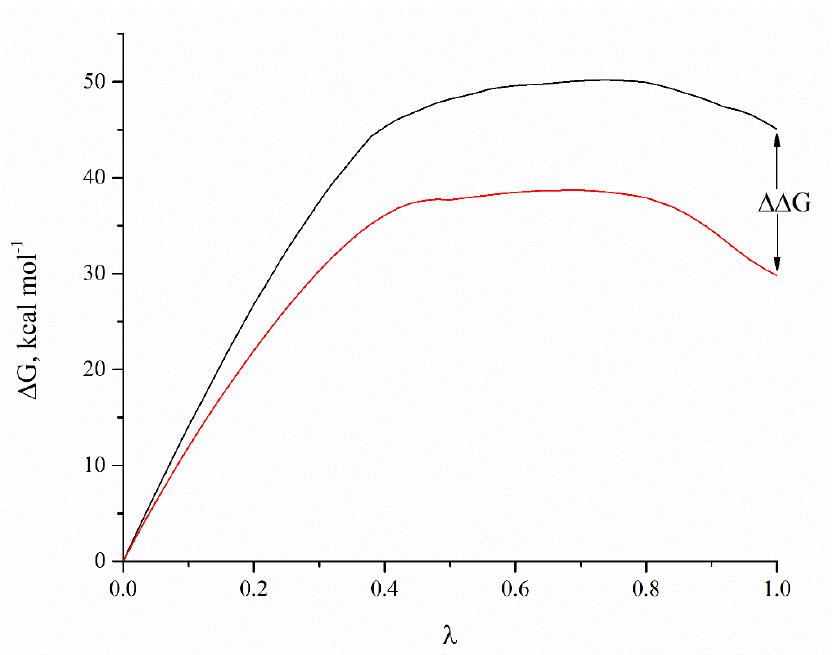
Figure 7. FEP results for bound (red line) and unbound (black line) conformation of the 5HT6– ZINC00756618 complex.